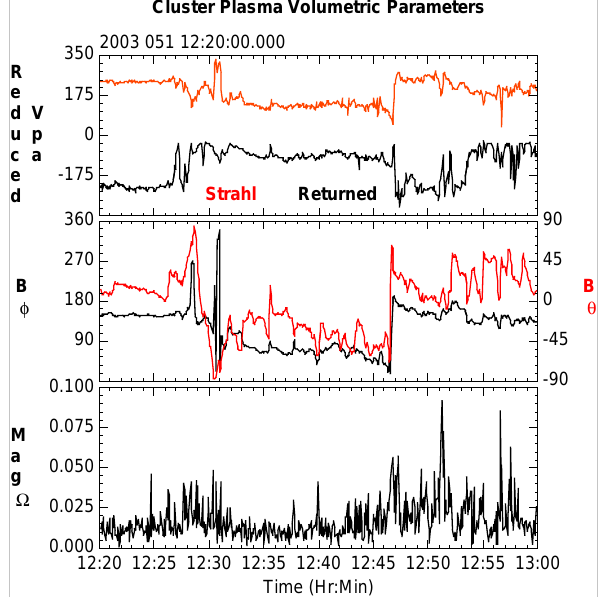
Fig. 8. High resolution plot of the parallel strahl and return veloci- ties, the φ and θ GSE components of the C1 magnetic field and the magnitude of the vorticity for the time surrounding the initial large increase in vorticity.